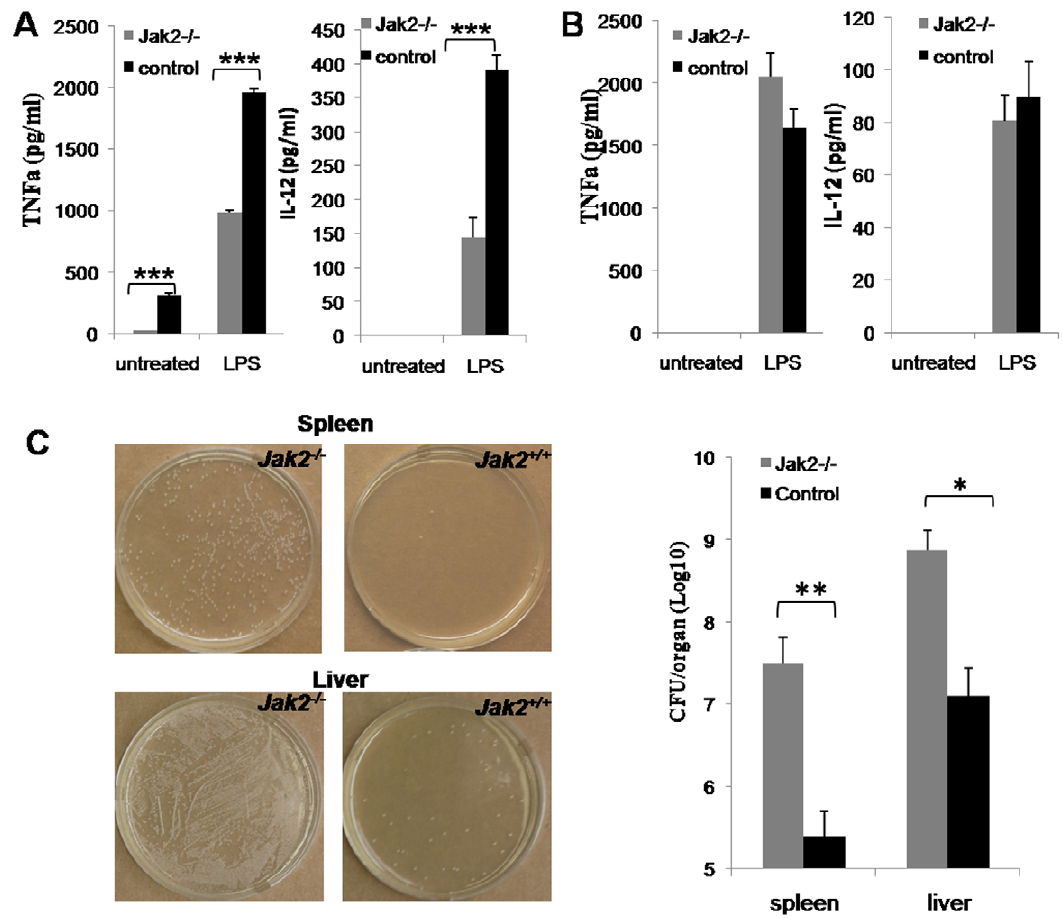
Figure 2. Jak2 deficiency selectively attenuates the capacity of DCs to initiate innate immune response. (A) Loss of Jak2 attenuates the capacity of DCs secretion of proinflammatory cytokines. Supernatants of BMDCs with or without LPS stimulation were harvested and subjected to ELISA analysis of cytokine secretion. BMDCs deficient for Jak2 showed significant reduced capacity to secrete TNF a and IL-12. (B) Jak2 failed to show perceptible impact on macrophages secretion of proinflammatory cytokines. PEM derived from Jak2 2 / 2 and control mice were cultured with or without LPS stimulation and supernatants were harvested for ELISA analysis as above, respectively. (C) Jak2 2 / 2 mice showed impaired early clearance of Listeria . Jak2 2 / 2 and control mice were i.v. injected with , 1 LD50 Listeria Monocytogenes in PBS. Spleens and livers were harvested after 48 h infection. Serial 10-fold dilutions of organ homogenates were plated on TSB-agar and CFU were counted after 48 h incubation. Left panel: a representative results for cultures inoculated with homogenates; right panel: a bar graphic figure showing the average CFU/organ of 3 independent experiments. All data are present as mean 6 SE. *, p , 0.05; **, p , 0.01; ***, p , 0.001.